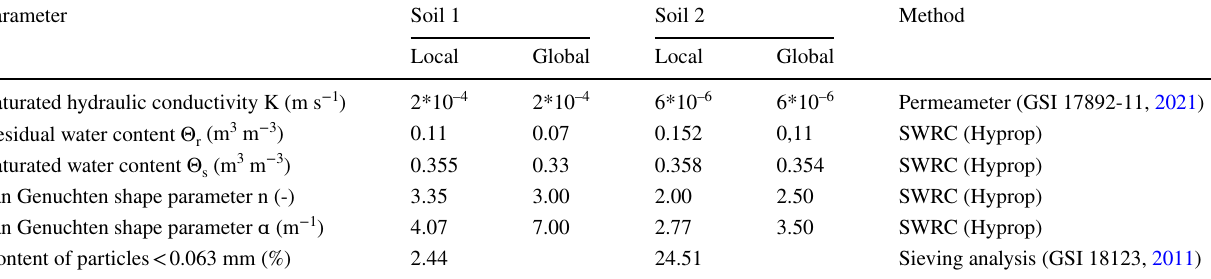
Table 1 Hydraulic parameters of the used soil materials—determined by local and global measurement